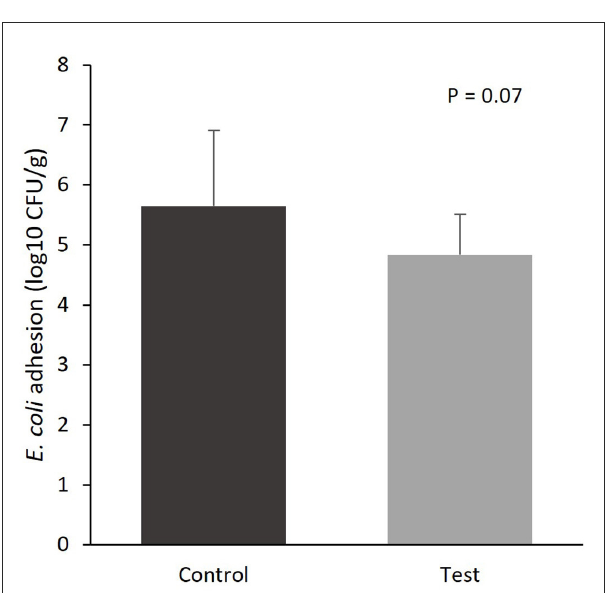
TABLE 6 Gene expression in the mucosal epithelium of the small intestine (section at 75% of small intestine length) of piglets at d14 post-weaning,